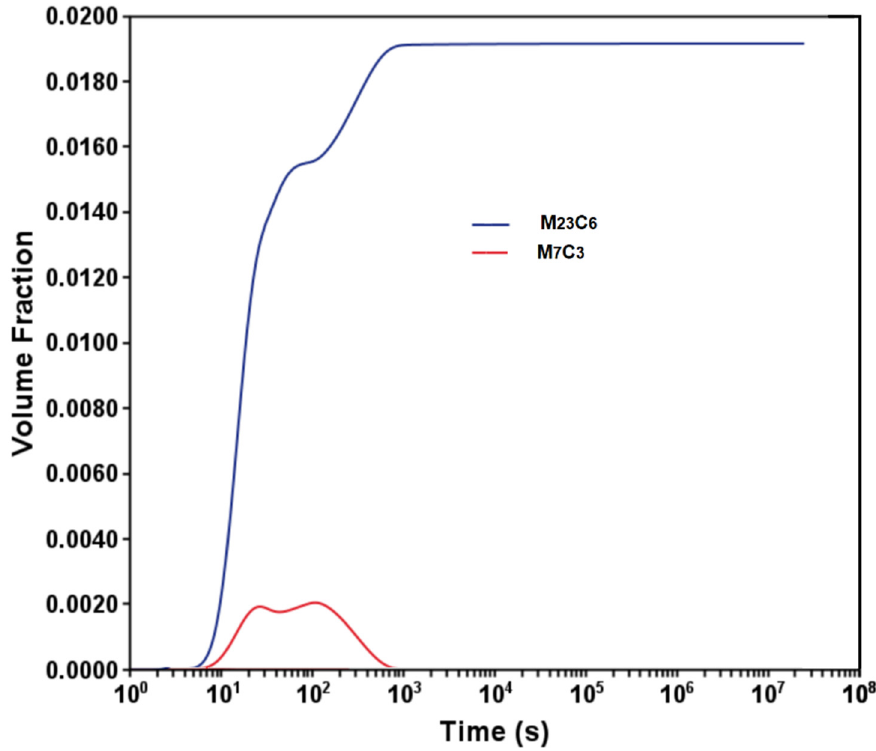
Figure 10. Calphad-calculated volume fraction of precipitates vs. time during aging at 600 °C.